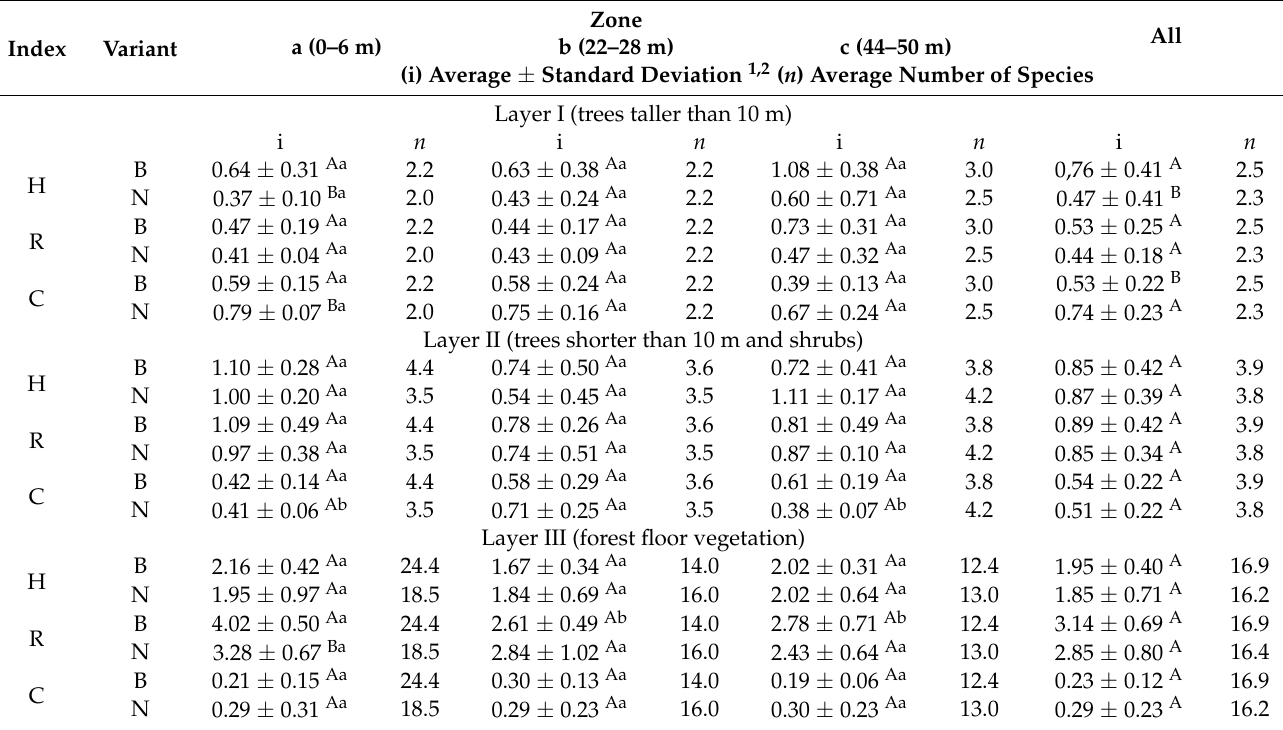
Table 3. Number of species and indicators of diversity of forest layers with or without beaver present and with distance from the watercourse. The average variation was determined for three plots with a combined area of 108 m 2 . B—plots with beaver, N—plots without